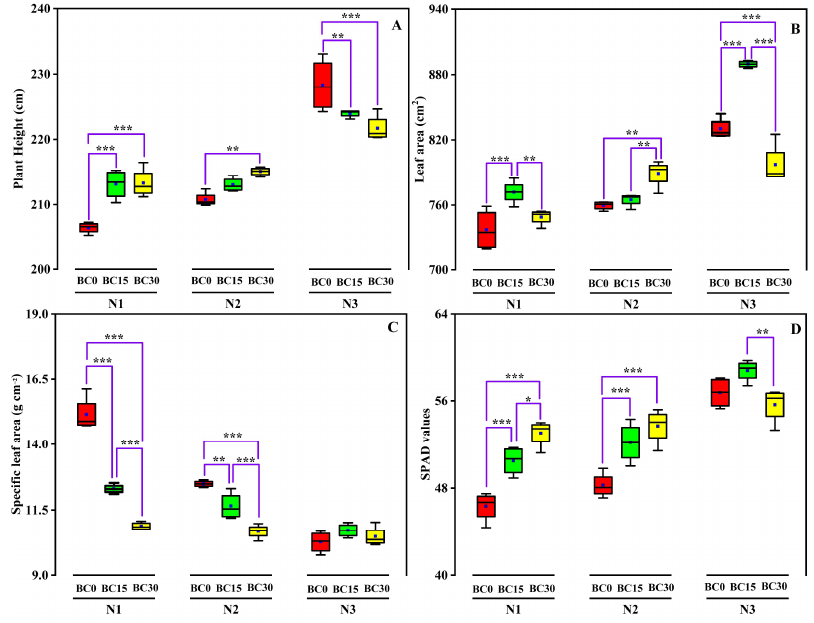
Figure 1. Effects of biochar on plant height ( A ), leaf area ( B ), specific leaf area ( C ) and SPAD values ( D ) of maize under different nitrogen fertilizer conditions. Significance levels are indicated: * p < 0.05, ** p < 0.01, *** p < 0.01.